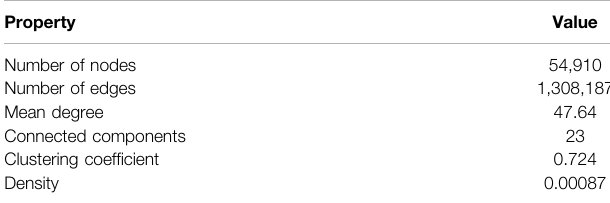
TABLE 1 | Statistical overview of the constructed MeSH network of chemicals. This network is the prunned version of the one constructed directly from the MeSH annotations, as MeSH terms that are too rare: frequency < 2 were not accounted